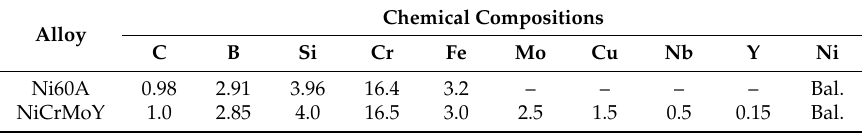
Table 1. Chemical compositions of the NiCrMoY and Ni60A alloy powders (wt %).